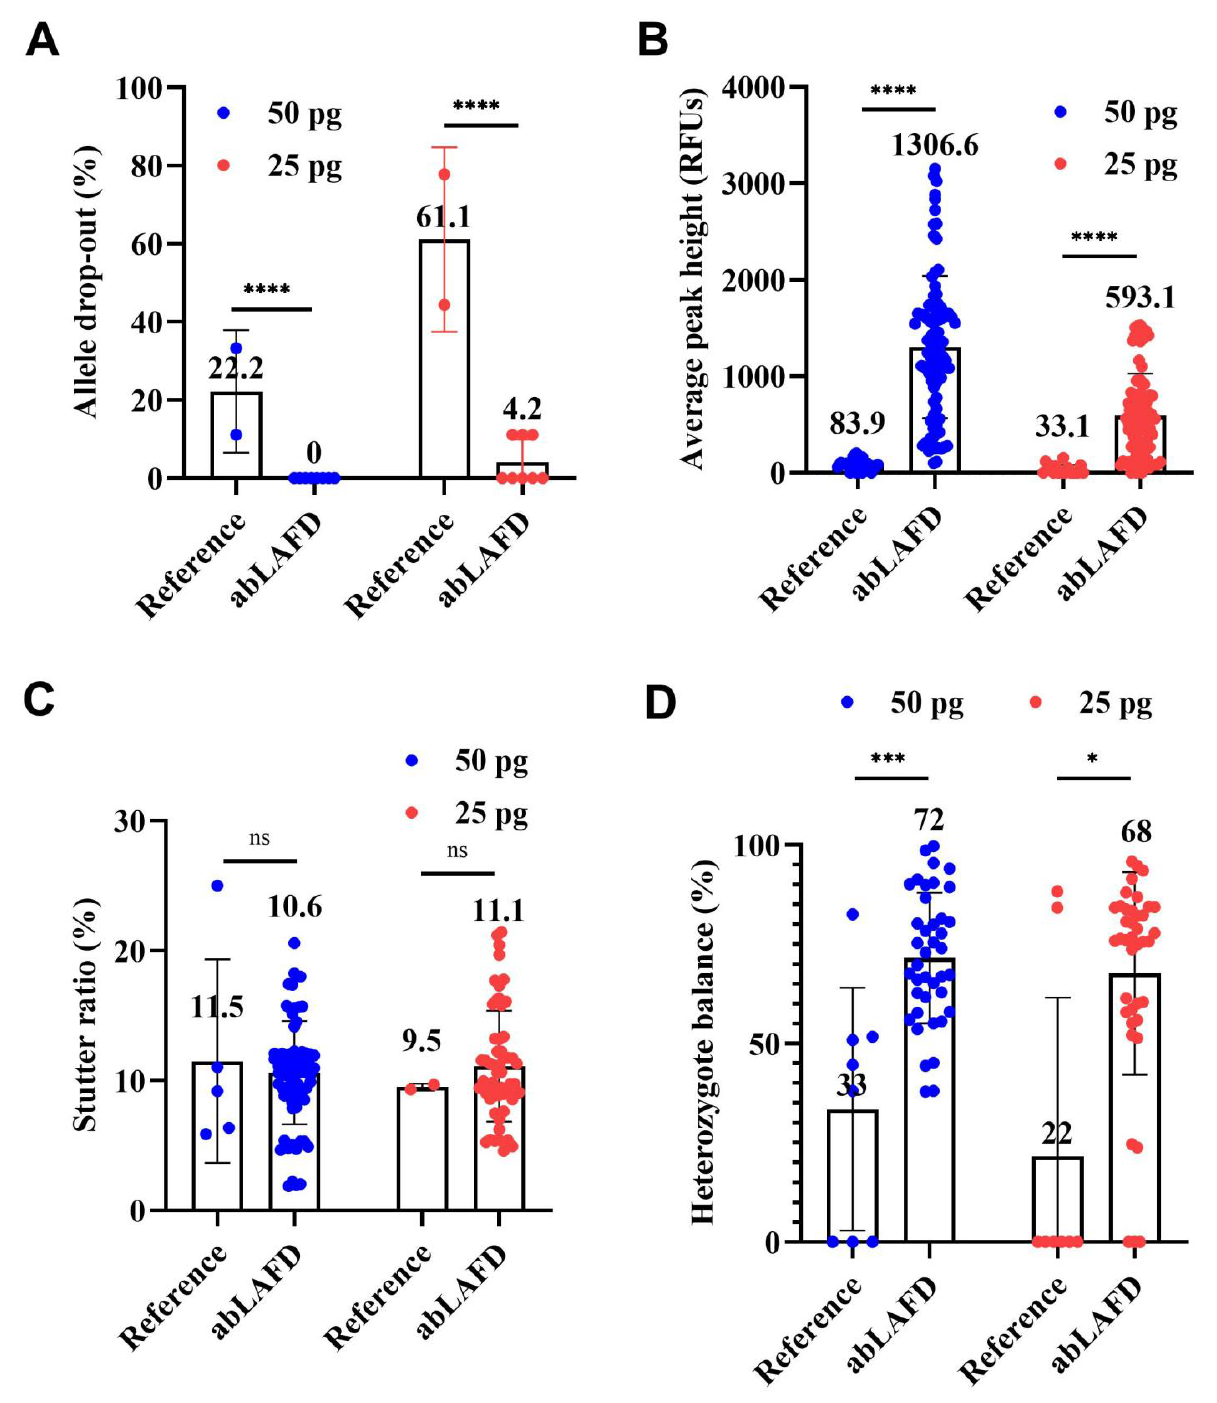
Figure 4. Comparisons among reference profiles and abLAFD profiles amplified from 50 pg DNA and 25 pg DNA. A peak amplitude threshold of 50 RFUs was set for allele calling. The mean value of each dataset was shown above each bar. The threshold significance level was set at 0.05 for each test. The symbols of “****” (or “***”), “*”, and “ns” can be defined as “extremely significant”, “significant”, and “not significant”, respectively. ( A ) The average rate of allele drop-out. It was obtained by direct counting. Significant differences were observed between abLAFD profiles and reference profiles for both 50 pg DNA ( p < 0.0001) and 25 pg DNA ( p < 0.0001). ( B ) The allele peak height. It was determined by the mean peak height of two alleles at heterozygous loci and halved peak height of the allele at homozygous loci. Alleles that failed to be called were recorded as 0